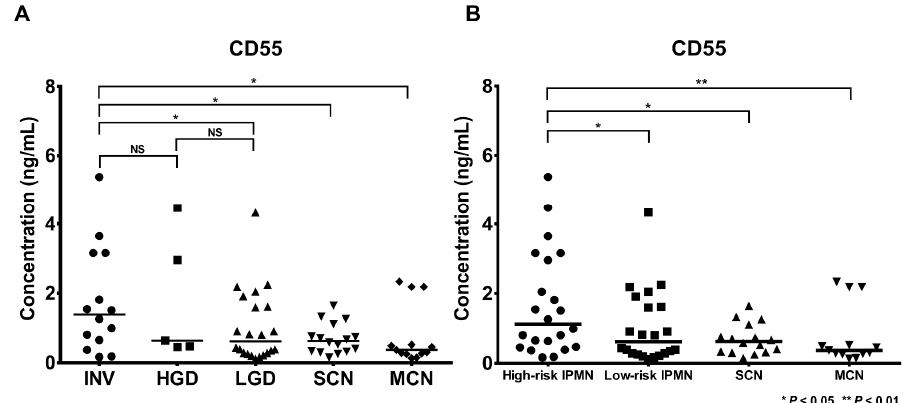
Figure 7. Validation of CD55 as a potential biomarker target by ELISA. ELISA was performed with CD55-specific antibodies to evaluate the validity of CD55 as a potential biomarker. The concentration patterns of CD55 by ELISA were generally consistent with the LFQ intensities. The CD55 concentrations are indicated according to two types of IPMN classification. The median CD55 concentrations were highest in invasive IPMN ( A ) and high-risk IPMN ( B ). LGD, low-grade dysplasia; HGD,